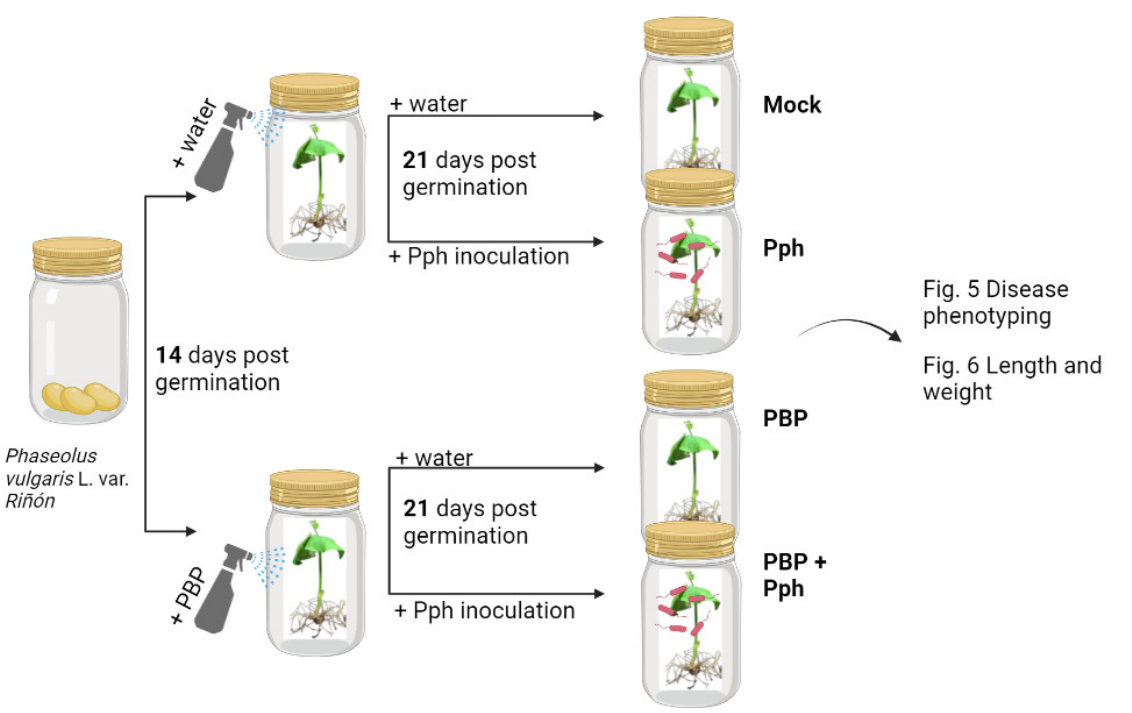
Figure 2. Experimental design for in vitro infections. Seeds of common bean P. vulgaris L. cultivar Riñón were grown in vitro. Leaves from common bean plants at V1 stage were sprayed with 1 mg/mL of plant-based products (PBPs) of Urtica dioica (U) or grapevine pomace (R G ) per leaf or with sterilized water (Mock condition). After 7 days, some plants previously treated or not with PBPs were sprayed with 2 mL of the Pseudomonas syringae pv. phaseolicola (Pph) solution on foliage leaves, resulting in U + Pph, R G + Pph, and Mock + Pph treatments. All plants were grown for 7 days more prior to phenotyping and measurement of length and weight.